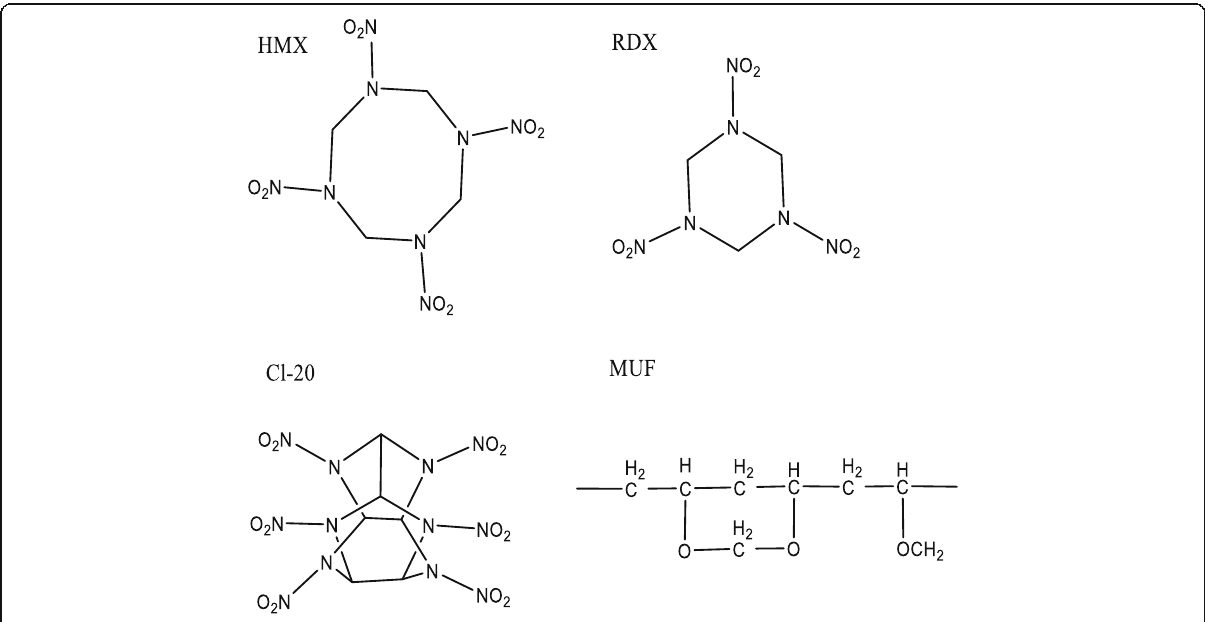
Fig. 1 Molecular structure of RDX, HMX, CL-20, and MUF Binder. R-CH2OH is